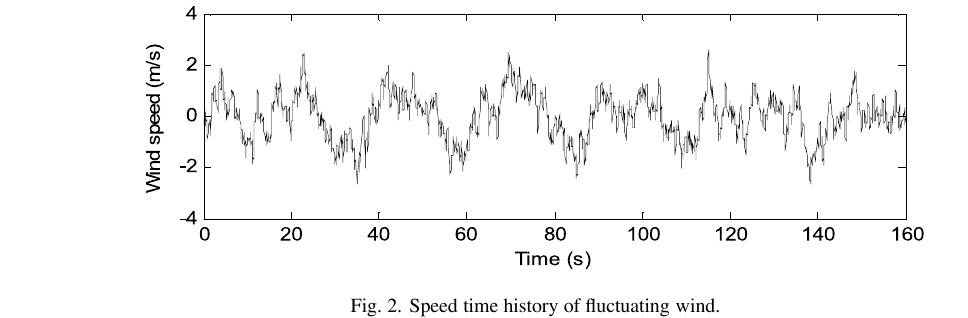
Fig. 2. Speed time history of fl uctuating